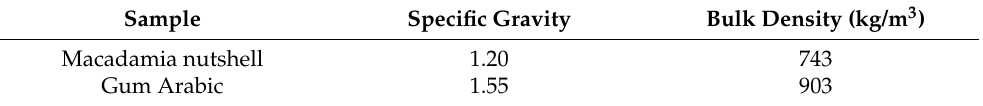
Table 1. Specific gravity and bulk density.